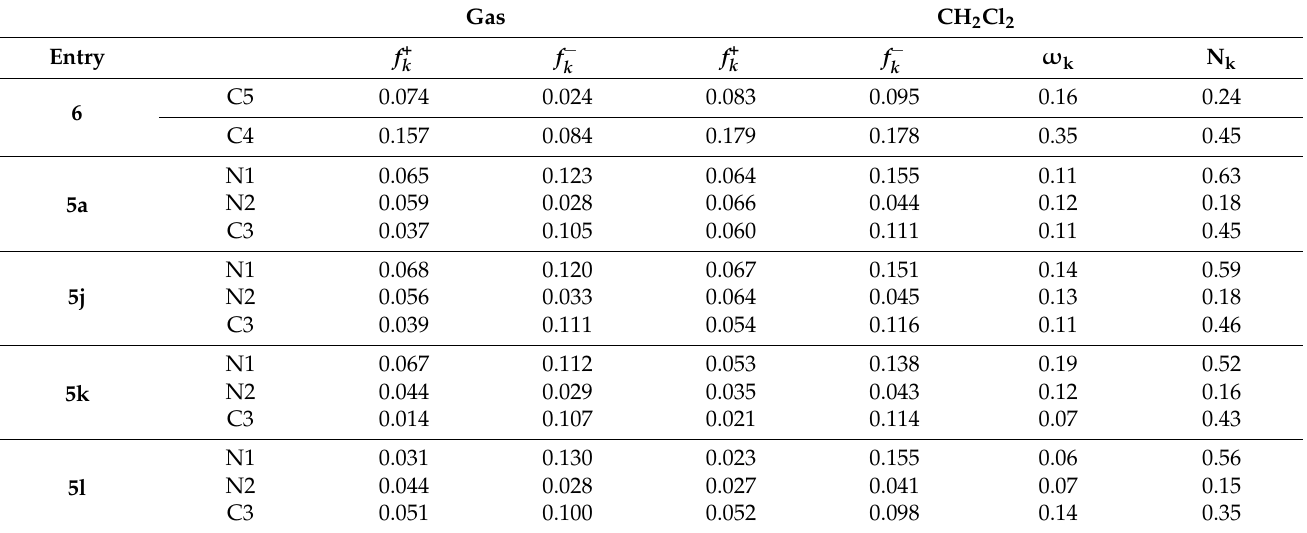
Table 4. Calculated Fukui functions and local electrophilicity ( ω k ) and nucleophilicity (N k ) at the reactive sites of nitrile imines 5a , j-l , and 5-methylidenehydantoin 6 .